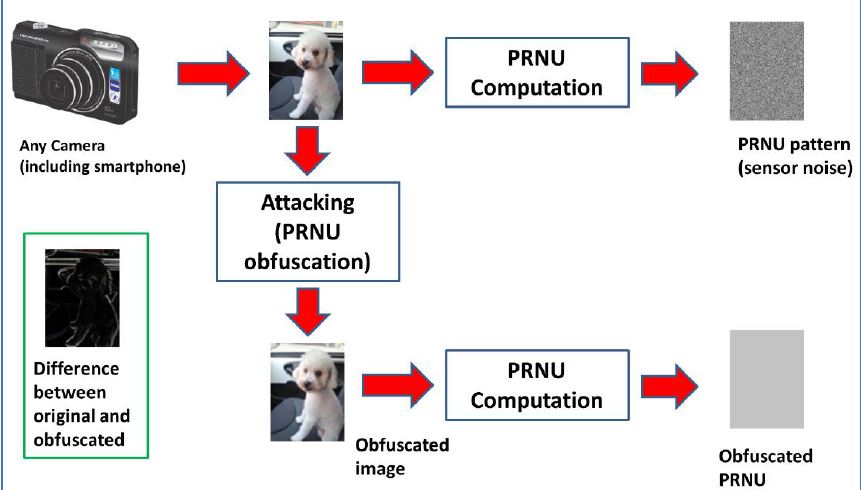
Figure 2. Concept of attack over PRNU - based SCI, graphical